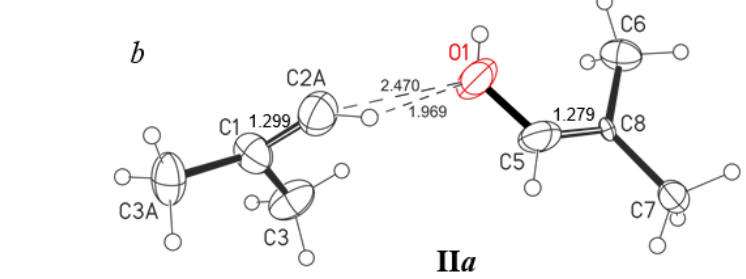
Figure 5. The C 4 H 7+ cation at two positions in the crystal lattice of salt (C 4 H 7+ · OHC 4 H 7 )(Cl 11 − ) Figure 5. The С 4 H 7+ cation at two positions in the crystal lattice of salt (С 4 H 7+ ‧ OHС 4 H 7 )(Cl 11 − ) (a) and ( a ) and the structure of the cationic adduct C 4 H 7+ · OHC 4 H 7 as ( b ) determined by X-ray crystallogra- the structure of the cationic adduct С 4 H 7+ ‧ OHС 4 H 7 as determined by X-ray crystallography. Intera- phy. Interatomic distances are given in tomic distances are given in Å . Table 3. Selected geometric parameter of cationic adduct II a according to X-ray data.